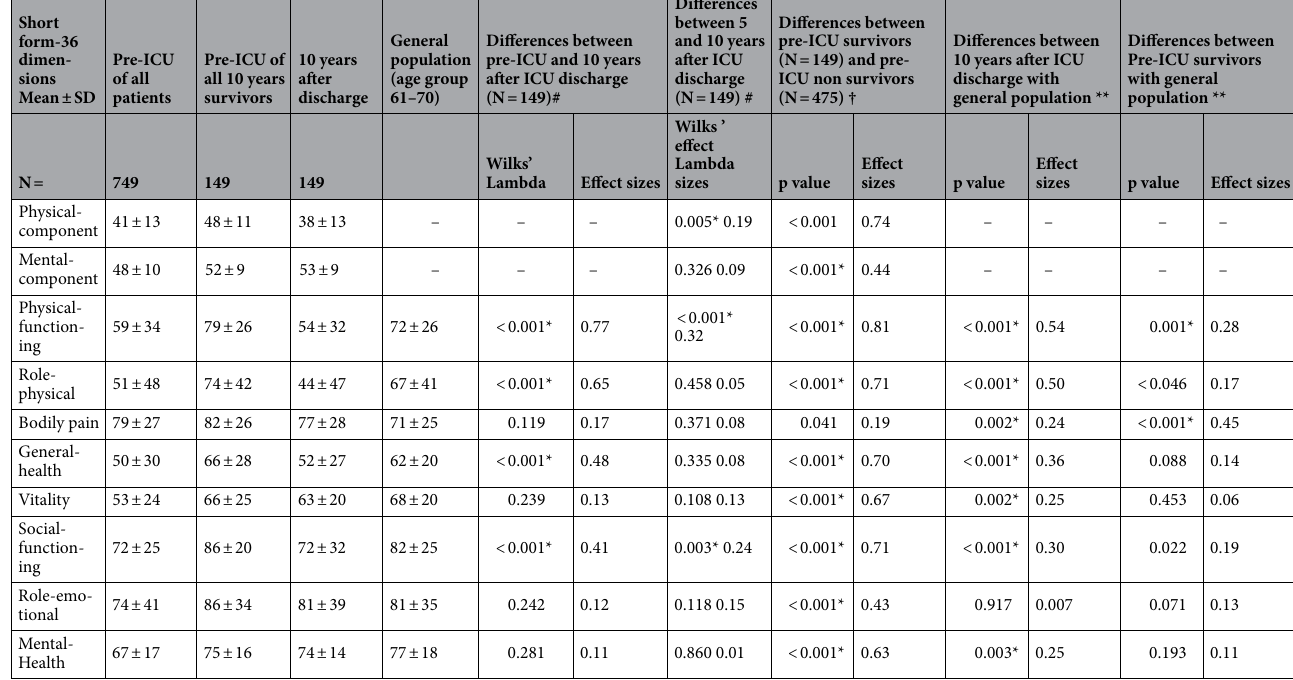
Table 4. Health-related quality of life in surviving patients and comparison with Dutch general population. Effect size: ≥ 0.20 small, ≥ 0.50 medium, > 0.80 large; Values indicate mean ± SD. † Univariate Analysis of Variance with Bonferroni correction p < 0.05 significant # GLM repeated measures with Bonferroni correction p < 0.05 significant. ** One sample T test. * P value significant after Bonferroni correction (p 0.05/10 = p = 0.005 = significant). SF-36 dimension scores are 0–100 scores. Population scores on Physical component score and Mental component scores have been standardized on a population mean of 50 with a